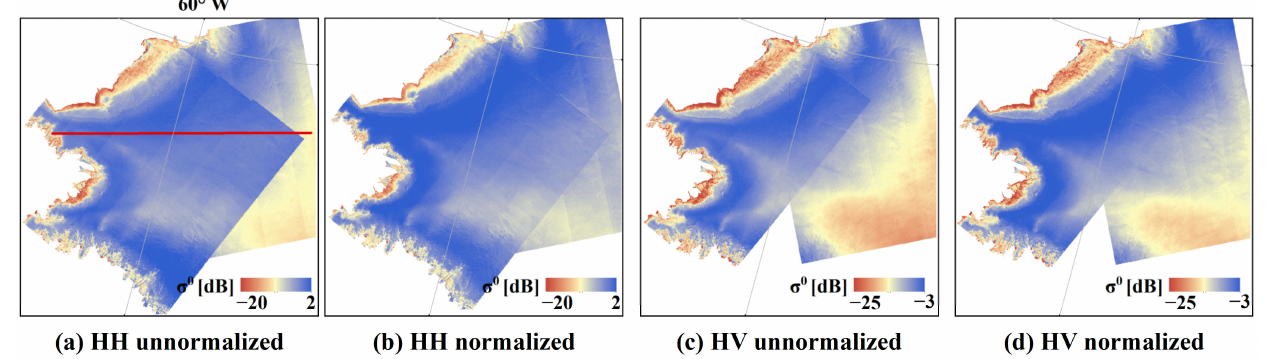
Figure 5. Mosaics of the image pair in EA3 (northwest Greenland, descending image on top) before ( a , c ) and after ( b , d ) incidence angle normalization by the incidence angle correction method. EW1 of HV images was removed. Both the ascending image and descending image were acquired on 3 February 2021. The temporal interval of the two images is about 9 h.